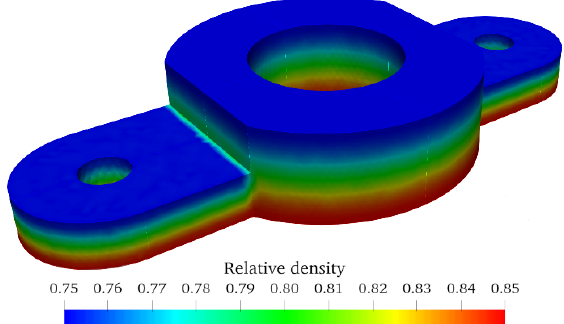
Figure 3. Initial relative density distribution for all simu- lations In order to reduce computing time both symmetries were exploited so only one quarter of the sample was modeled (see Figure 4). Symmetry boundary conditions were imposed on cutting planes, without additional constrains to simulate a free standing sample. The same finite element mesh was used both for thermal and mechanical simulations with 15948 tetrahedron finite elements.